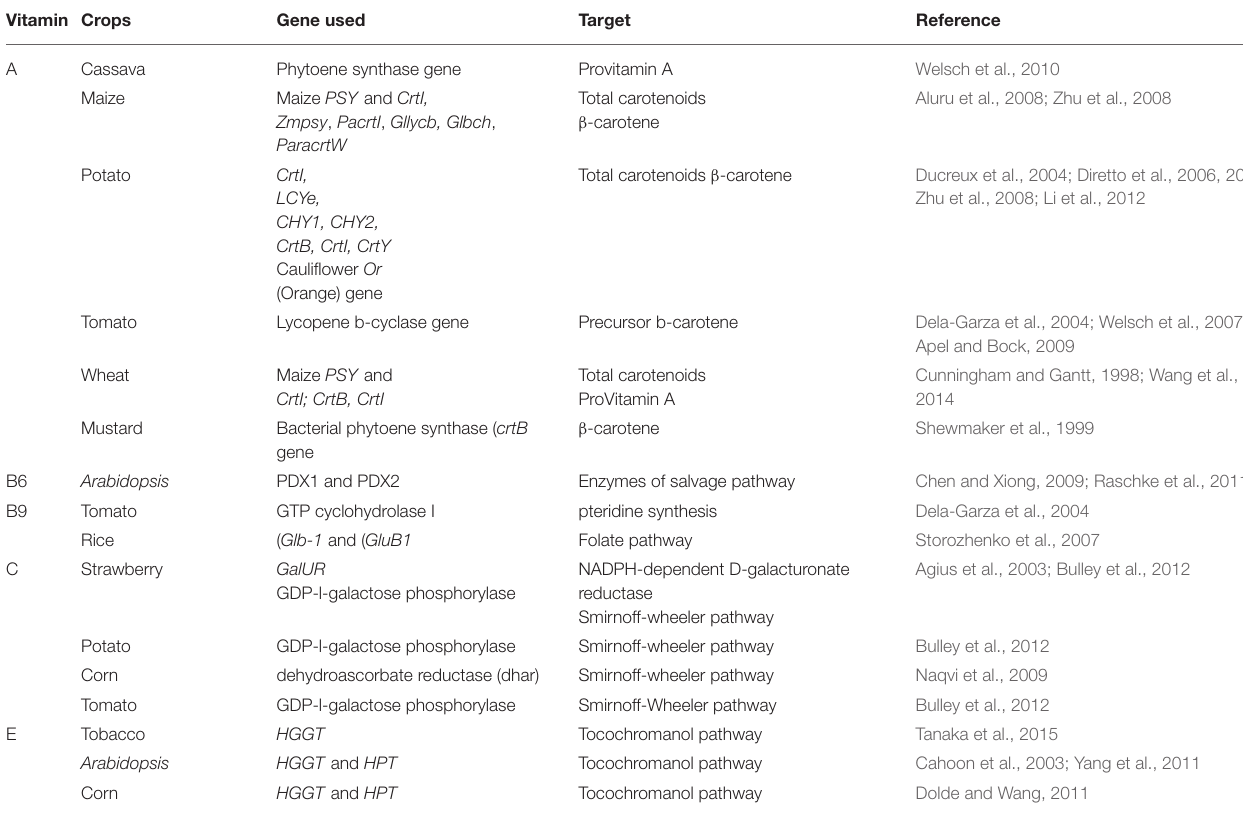
TABLE 2 | Transgenic biofortified crops with enhanced vitamin content. Vitamin